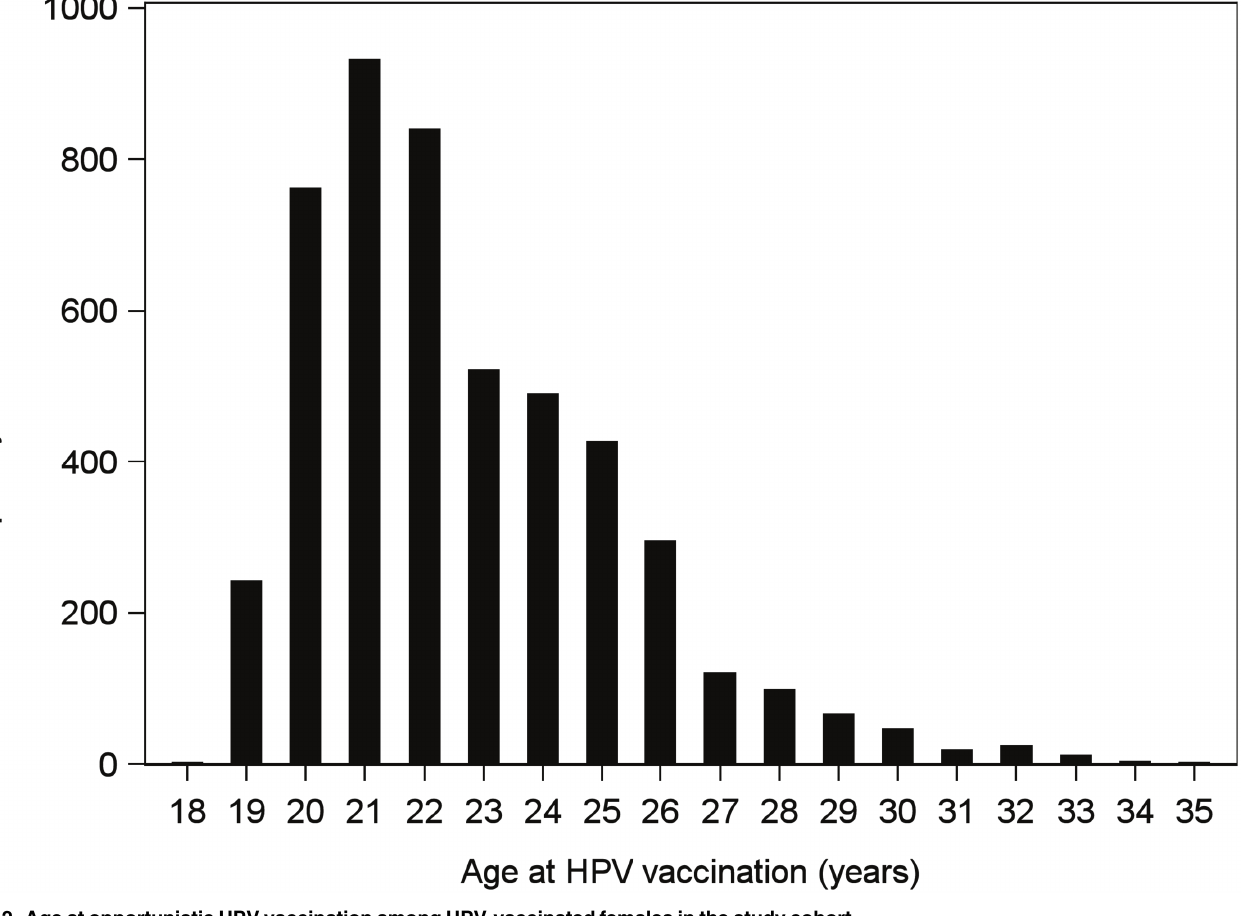
Fig 2. Age at opportunistic HPV vaccination among HPV-vaccinated females in the study cohort.